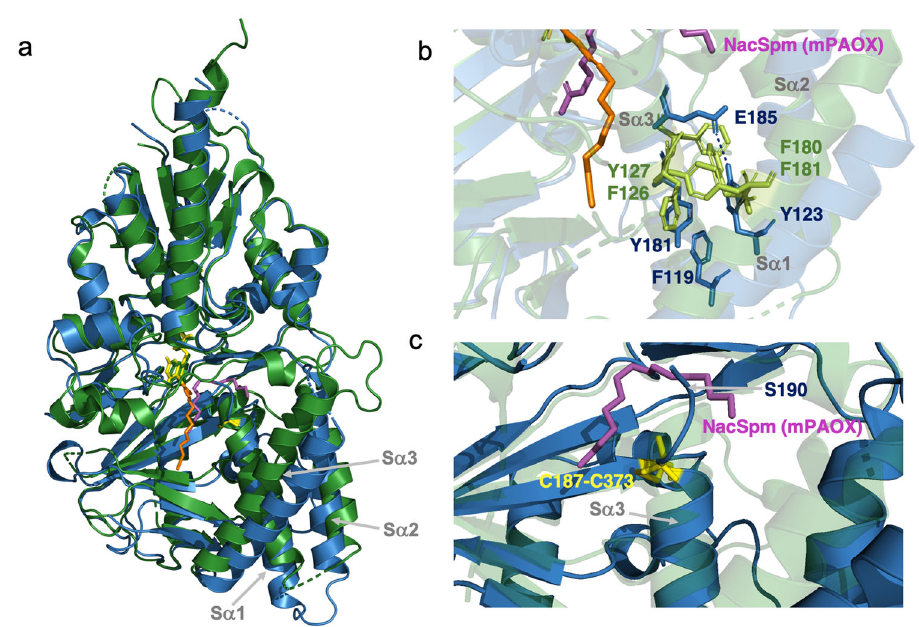
Fig. 4 Comparison of ehSMOX with mPAOX structures. a Superimposition of the ribbon representation of ehSMOX (in blue) bound to MDL72527 (in orange sticks) and mPAOX (PDB: 5MBX in green) with its substrate N -AcSpm (in magenta sticks). FAD is depicted in yellow and green, respectively for ehSMOX and mPAOX and the ehSMOX cystine bridge (Cys187-Cys373) is shown in yellow sticks. b Residues involved in π -interactions are in light green sticks for mPAOX and in blue for heSMOX; the dashed line indicated the additional H-bond between E185 and Y123 only present in ehSMOX. c The S α 3 helix of mPAOX (transparent green ribbon) is longer compared to ehSMOX and directed towards the back of the protein. In ehSMOX, the cysteine bridge depicted in yellow sticks indicates the end of helix S α 3 and the beginning of the loop directed in the opposite direction compared to mPAOX. Residue S190 of heSMOX clashes with the N-AcSpm (in magenta stick) superimposed from mPAOX